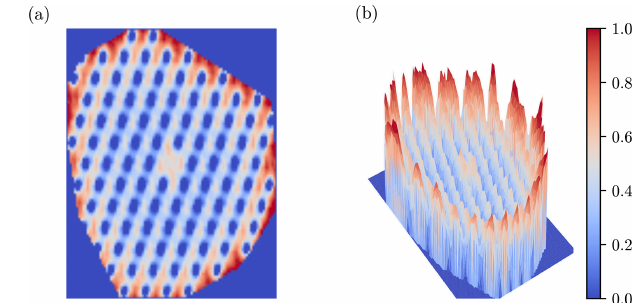
Figure 1. The complexity and multimodality of wind farm layout design space. Shown is the normalized annual energy production of a 100-turbine wind farm as a function of the location of one turbine; 99 turbines remain fixed, while one is moved throughout the wind farm. (a) A 2-D view of the design space. (b) A 3-D surface, which highlights the extreme variation of the peaks and valleys. This figure shows only the multimodality from two dimensions, where the true design space has 200 design variables.